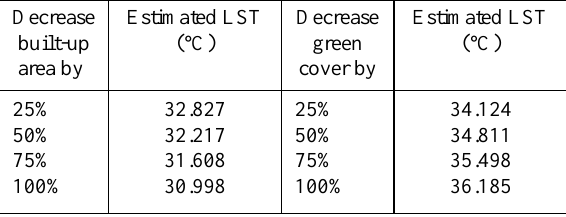
Table 7: Estimated LST value if both parameters are decreased by 25%, 50%, 75% and 100% of the current built-up area and green cover values in Bukit